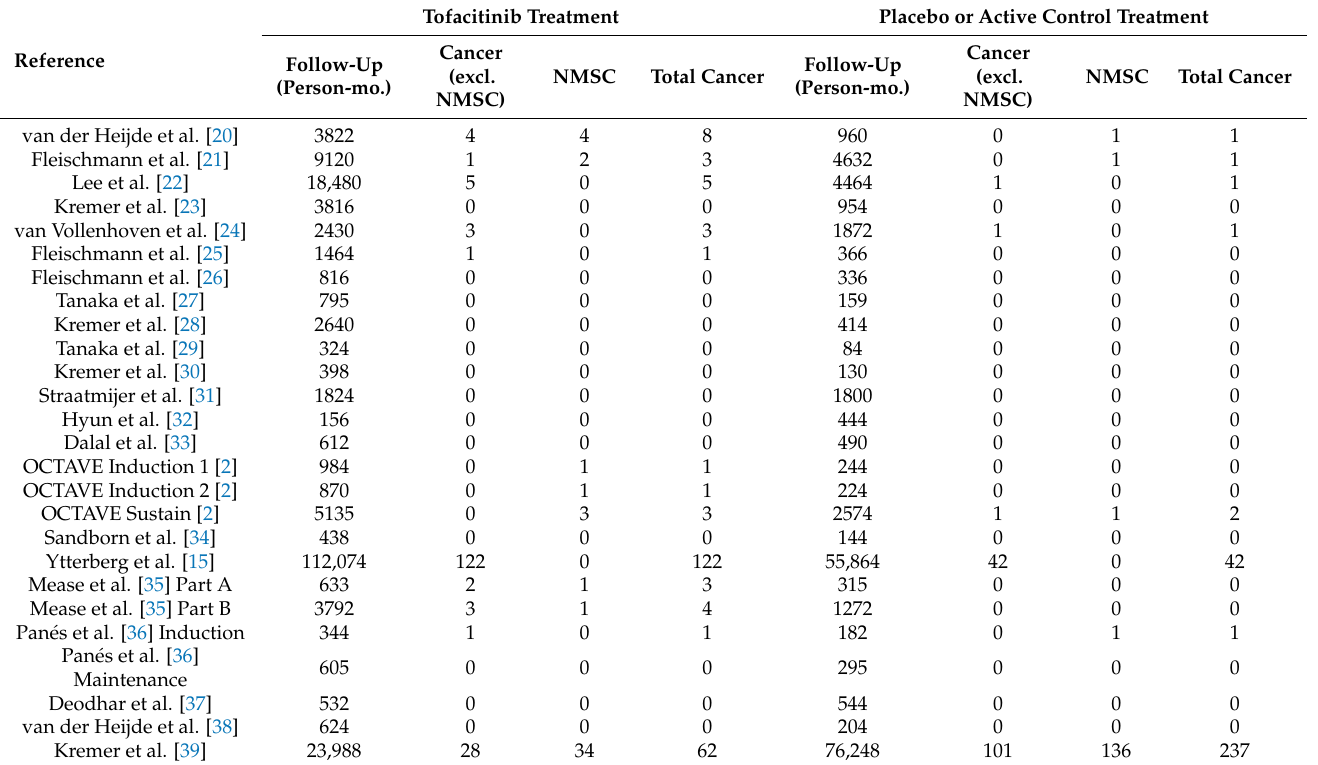
Table 3. Follow-up duration and numbers of tumors detected in the included studies, by treatment group.